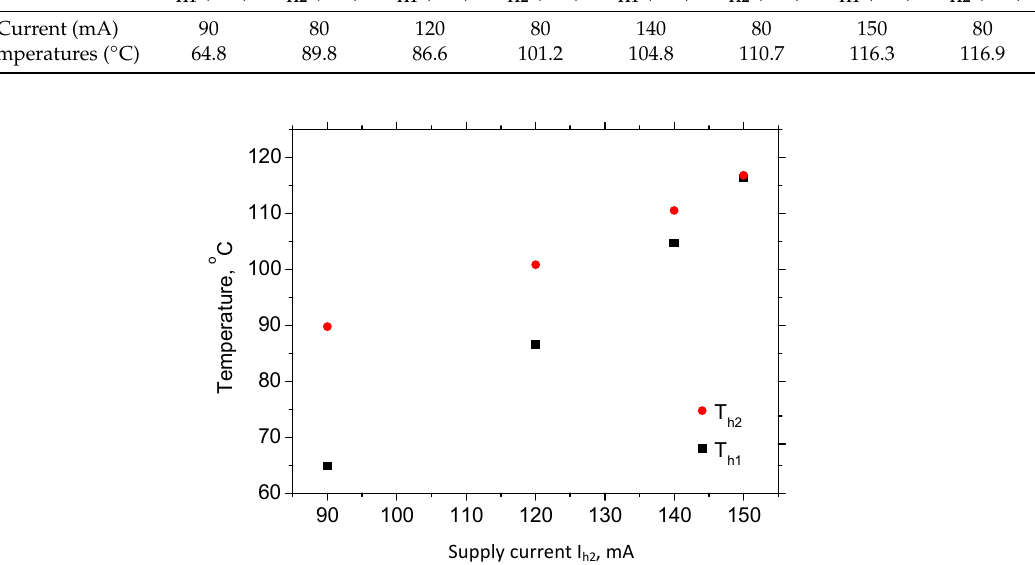
Figure 6. Time evolution of temperature for I H2 = 80 mA and I H1 = 120 mA during 20 min.